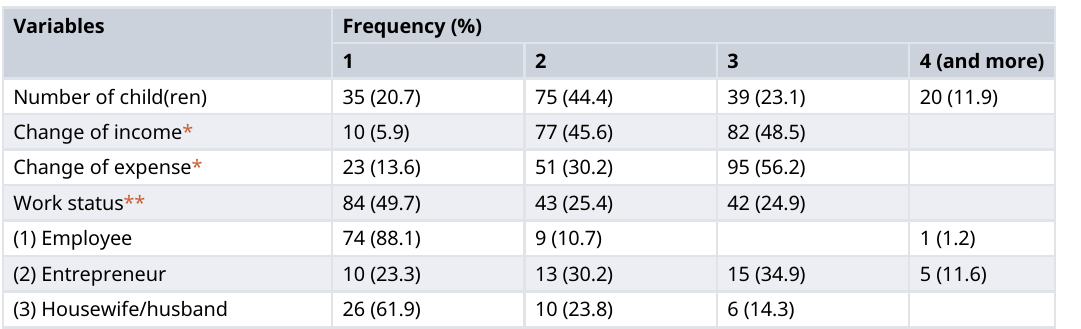
Table 2. Frequency of demographic